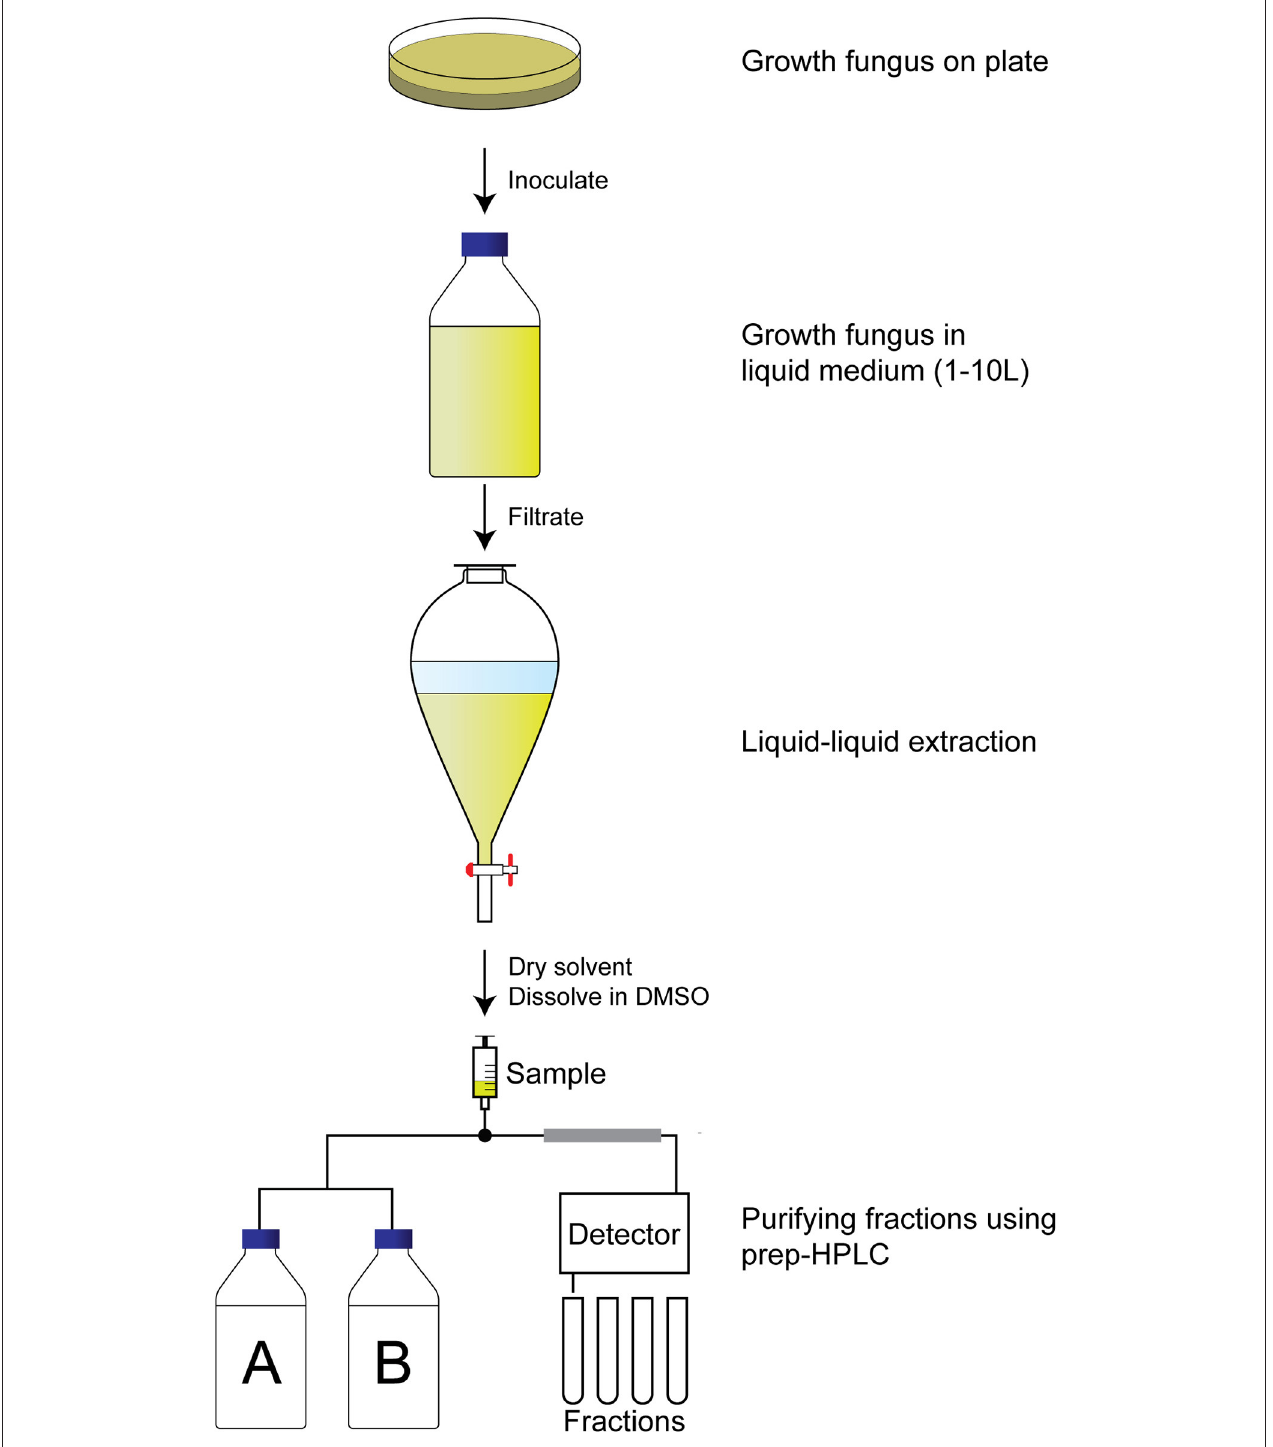
FIGURE 2 | Activity-guided purification approach to identify QS inhibitors. A fungus of interest is grown on an agar plate for a week before inoculation in large volume (1–10L) for another week under preferred conditions. The supernatant is then filtrated before liquid–liquid extraction with ethyl acetate. The ethyl acetate is dried, and the pellet is dissolved in DMSO before fractionating the extract using a preparative HPLC. Fractions are dried and tested for QS inhibitory activity before identification of the fraction.